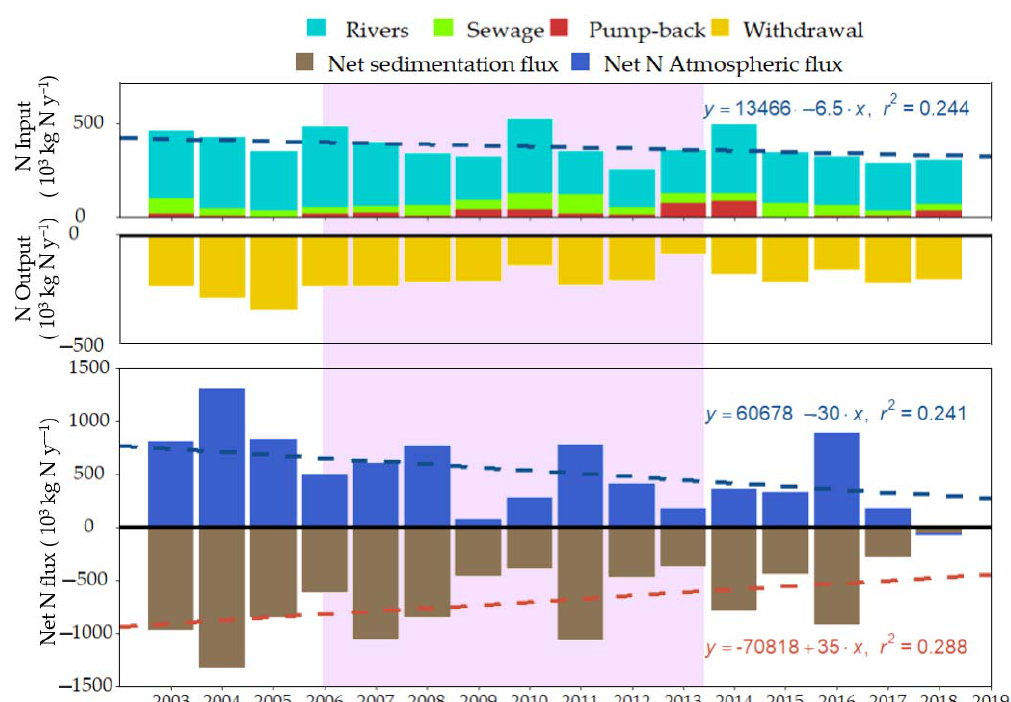
Figure 5. Annual N budgets for VB from 2003 − 2018. Top panel shows the inputs from rivers, sewages and pump-back from the other reservoirs of the Cutzamala System. Middle panel depicts the output through water withdrawal. Bottom panel shows NIP ( N ) yielded by the N budget. The full bar depicts NIP ( N ) , the total net change in N in the reservoir due to both atmospheric and sedimentary exchange fluxes. Brown bars correspond to the net N annual flux to the sediments NIP ( N ) Sed , as assessed from the P net sedimentation shown in Figure 4. Blue bars show the net N atmospheric flux, NIP ( N ) Atm , calculated after subtracting NIP ( N ) Sed from the total NIP ( N ) . Dashed lines in the top and bottom panels indicate the input and NIP ( N ) trend for the 2003–2018 period overall. They correspond to linear regressions together with their correlation